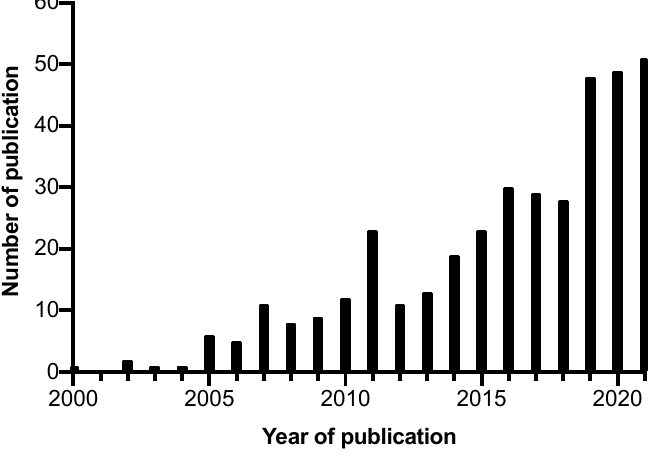
Figure 2. Number of publications on the cost assessment of AOPs for textile wastewater treatment during the last two decades (source: Advanced search in Scopus; accessed on 30 November 2021; keywords: textile wastewater AND advanced oxidation process AND water AND electrical energy per order, Link: